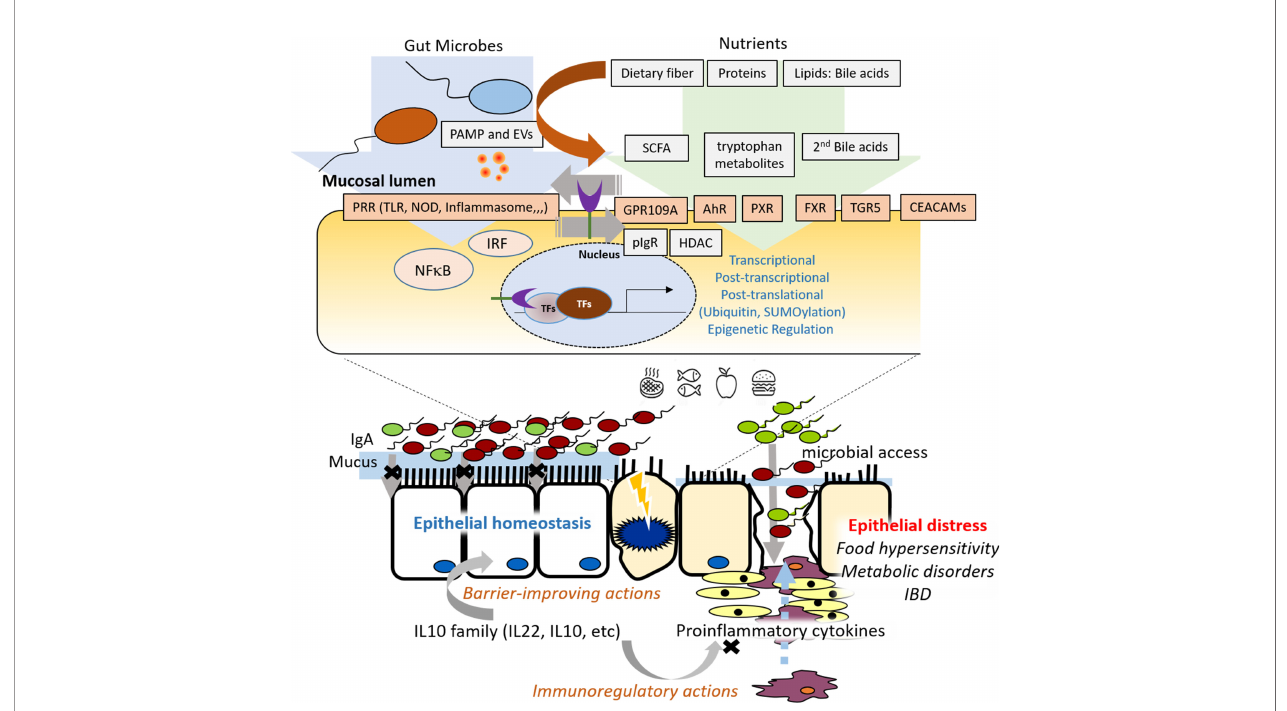
FIGURE 1 | Graphic summary of the research topics on molecular pathways controlling epithelial in fl ammation in the